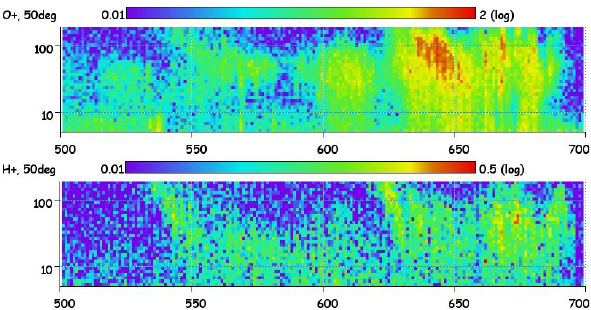
Fig. 4. Energy spectra [eV] of protons and oxygen near near 50 ◦ pitch angle as a function of time [s] from T+500s to T+700s. Color bar proportional to differential energy flux eV/cm 2 /s/sr/eV, arbitrary